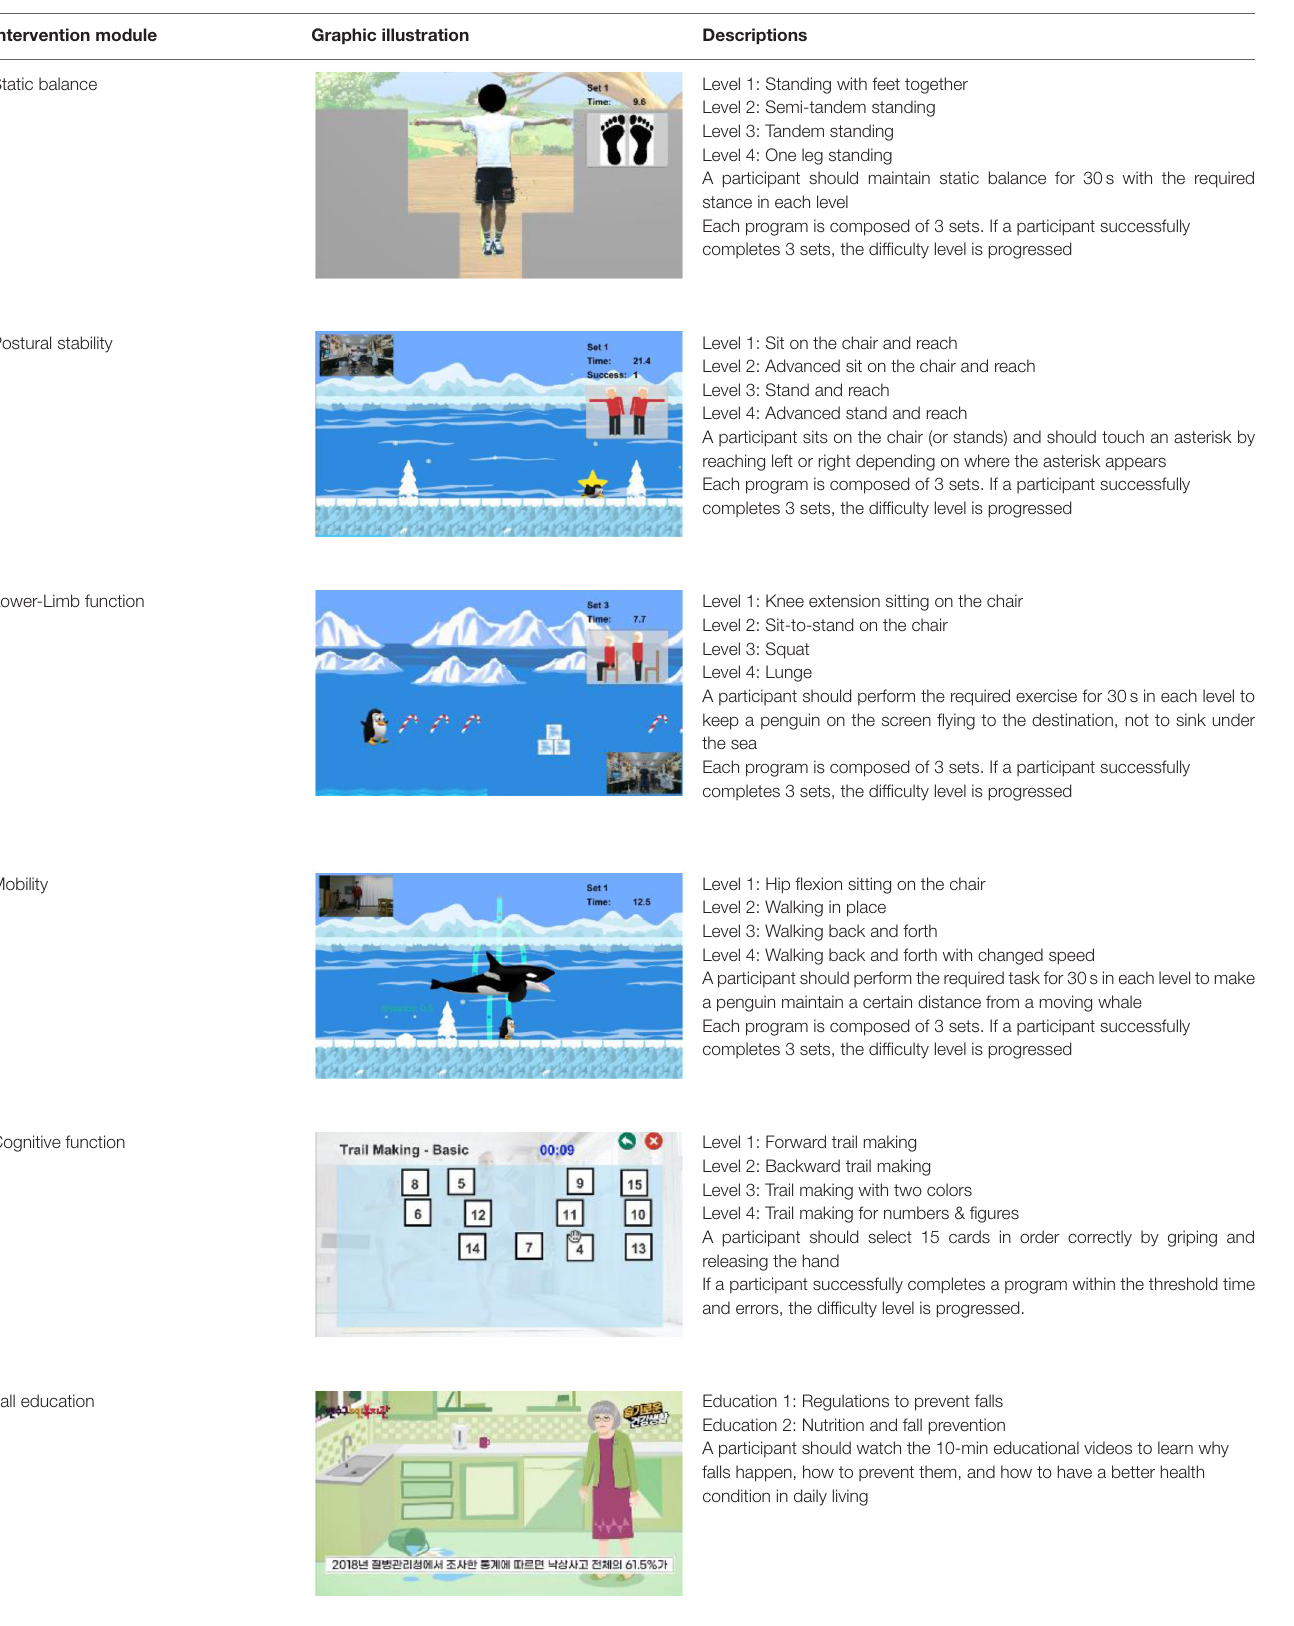
TABLE 2 | Kinect-based modular fall intervention programs and